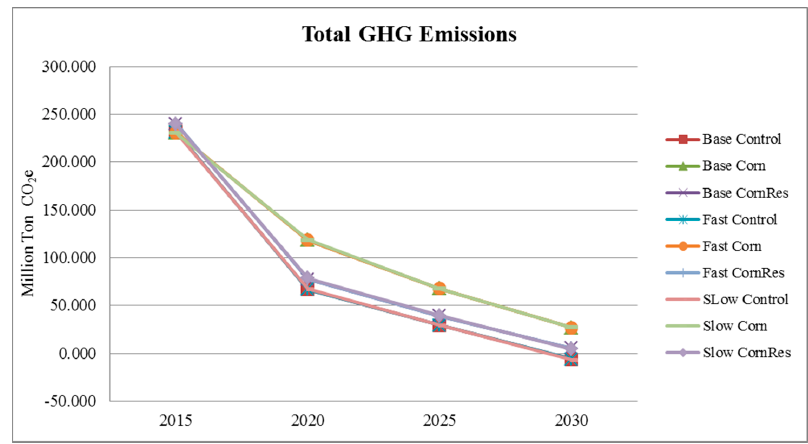
Figure 7. Average total GHG emissions projection during 2015 to 2030.